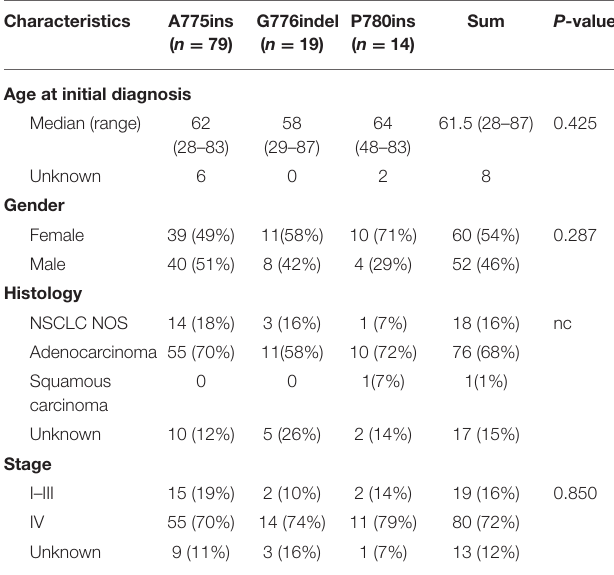
TABLE 1 | Clinical characteristics of patients with ERBB2 exon 20 insertion in different